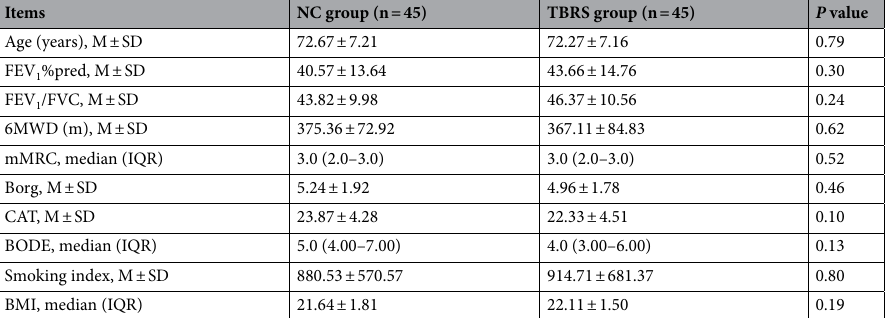
Table 1. The main data at baseline (before the interventions). FEV1, forced expiratory volume in 1 s; FEV1%pred, forced expiratory volume in 1 s% prediction; FVC, forced vital capacity; 6MWD, 6-min